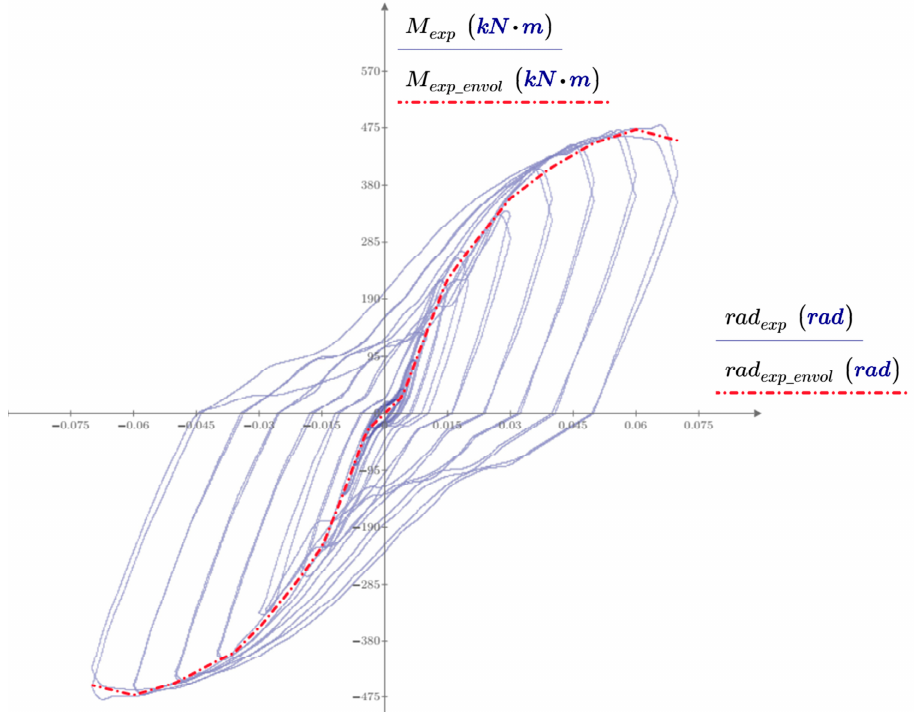
Figure 11. Experimental moment-rotation envelope.